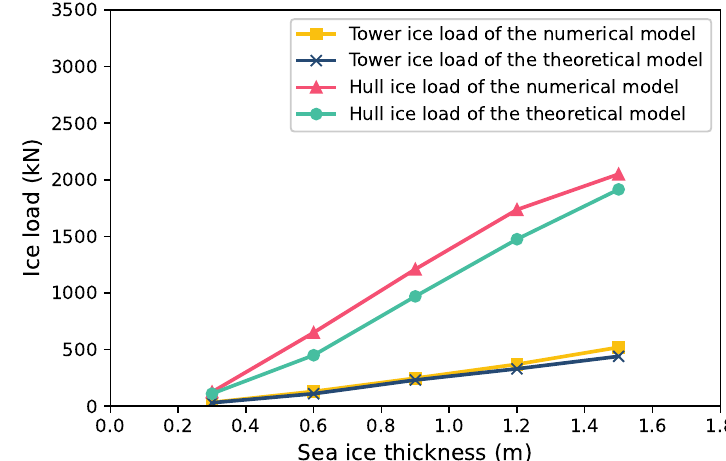
Figure 9. The relationship between submarine ice load and sea ice thickness.